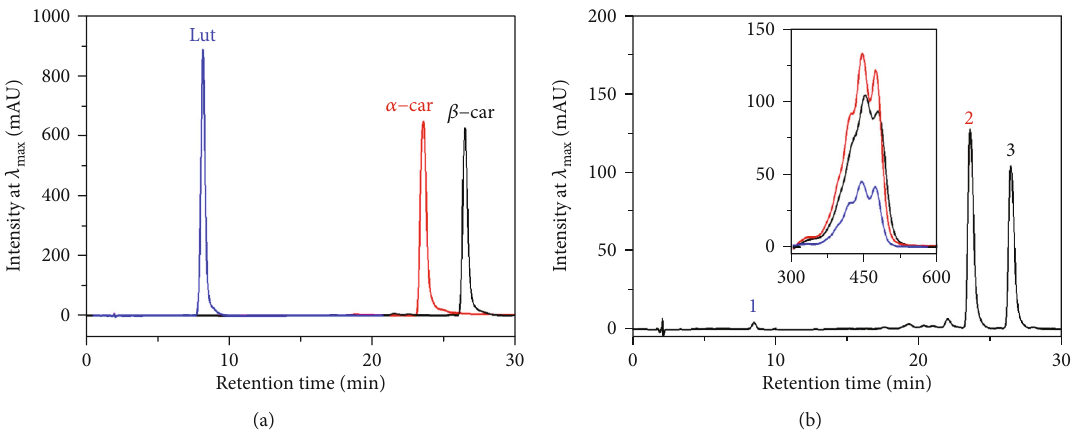
Figure 2: HPLC chromatogram pro fi le of the standard lutein, i.e., α -car and β -car (a), and the extracts of the Agung Semeru plantain fruits at ripening stage 5 (b). The inset fi gure is the absorption spectra of the lutein (blue), α -car (red), and β -car (black) in the HPLC